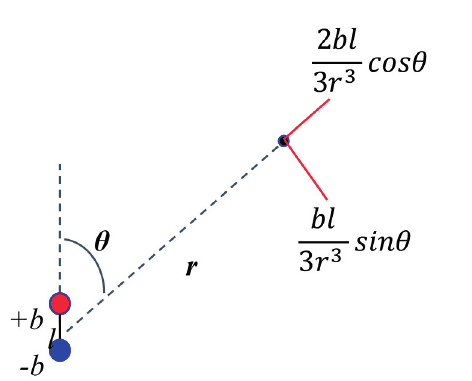
Figure 4. Field calculation angle and radial